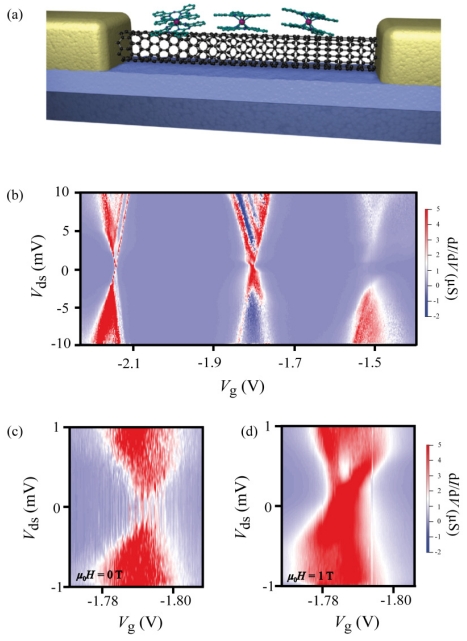
Electronic transport in carbon nanotube quantum dots with grafted TbPc2 molecules. (a) Artist view of the device scheme, consisting of an electrically connected carbon nanotube junction, laterally coupled to isolated TbPc2-SMMs; (b) Color-scale plots of the differential conductance dI/dV at temperature T = 40 mK, as a function of source-drain voltage Vsd and back-gate voltage Vg, displaying the charge stability diagram in the Coulomb blockade regime. The typical charging energy is about 20 meV; (c–d) Enlarged views of (b), showing the charge degeneracy point around Vg = 1.79 V at constant static magnetic fields (c) μ0H = 0 T and (d) μ0H = 1 T.